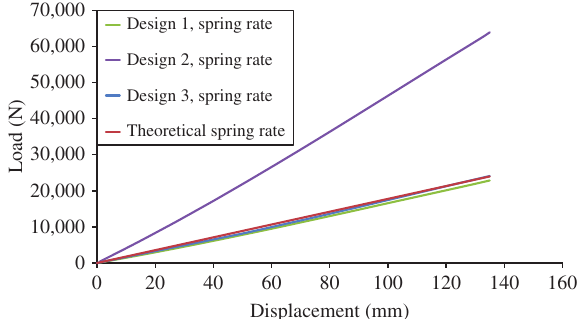
Figure 7: Load vs. displacement response comparison of the designed springs.